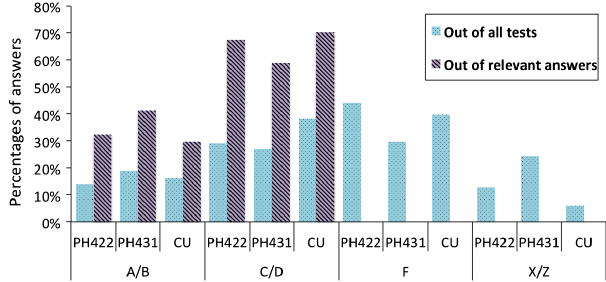
FIG. 9. Frequency of correct (A or B), incorrect (C or D), irrelevant (F), and lack of answer (X or Z) at OSU and CU out of ¼ 86 , N ¼ 68 , blue dotted pattern) and out of all tests ( N OSU CU ¼ 37 , N ¼ 37 , purple hatched only relevant answers ( N OSU CU